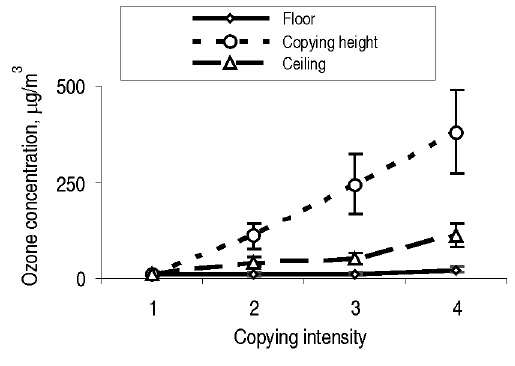
Fig 4. Ozone concentration in room by copying